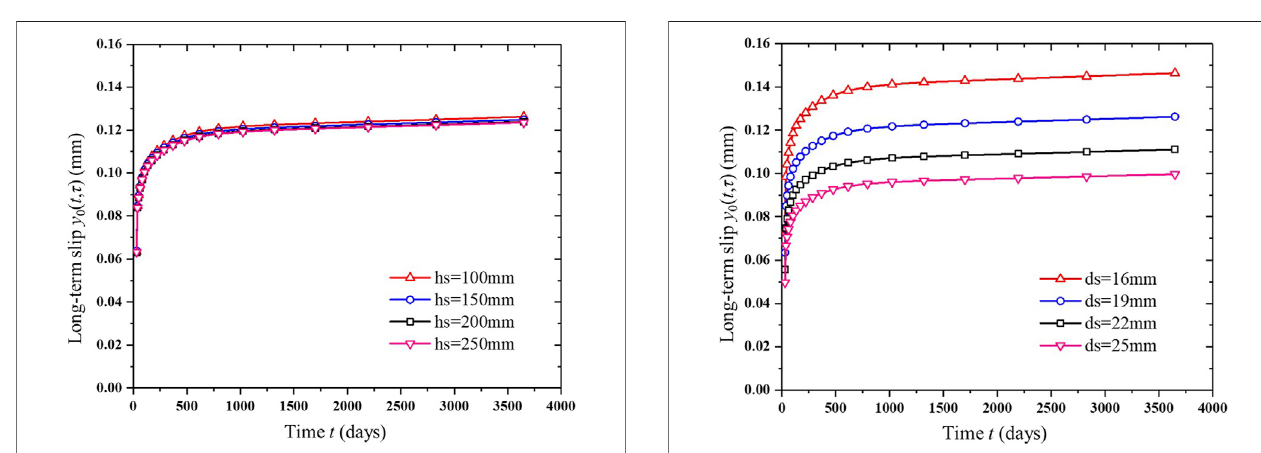
FIGURE 5 | Time dependent relative slip with increasing stud height.